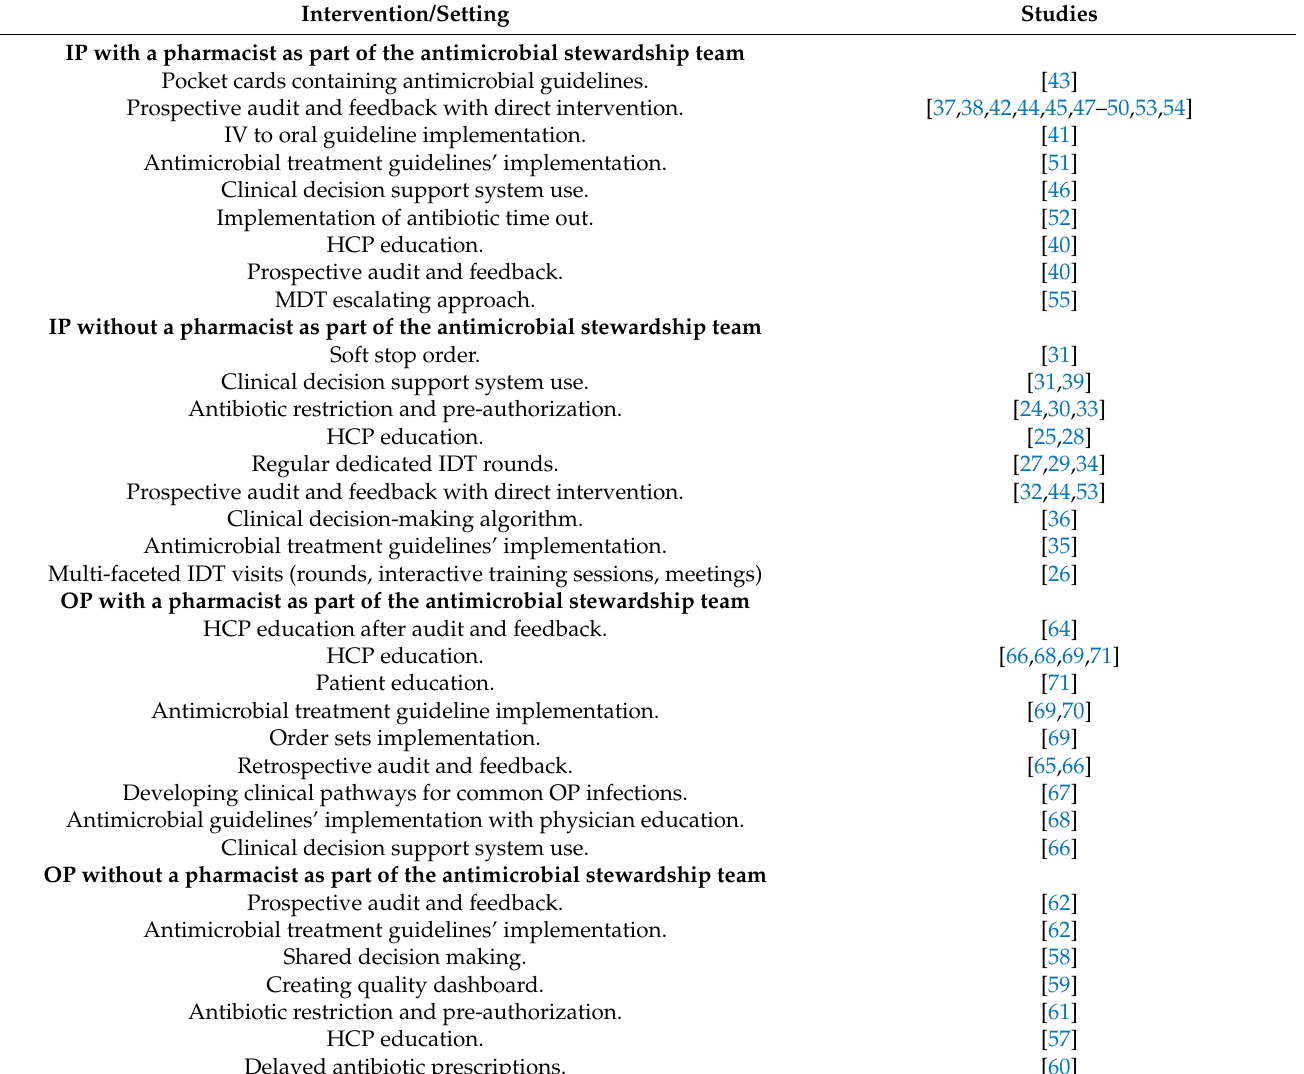
Table 2. Types of intervention per setting.